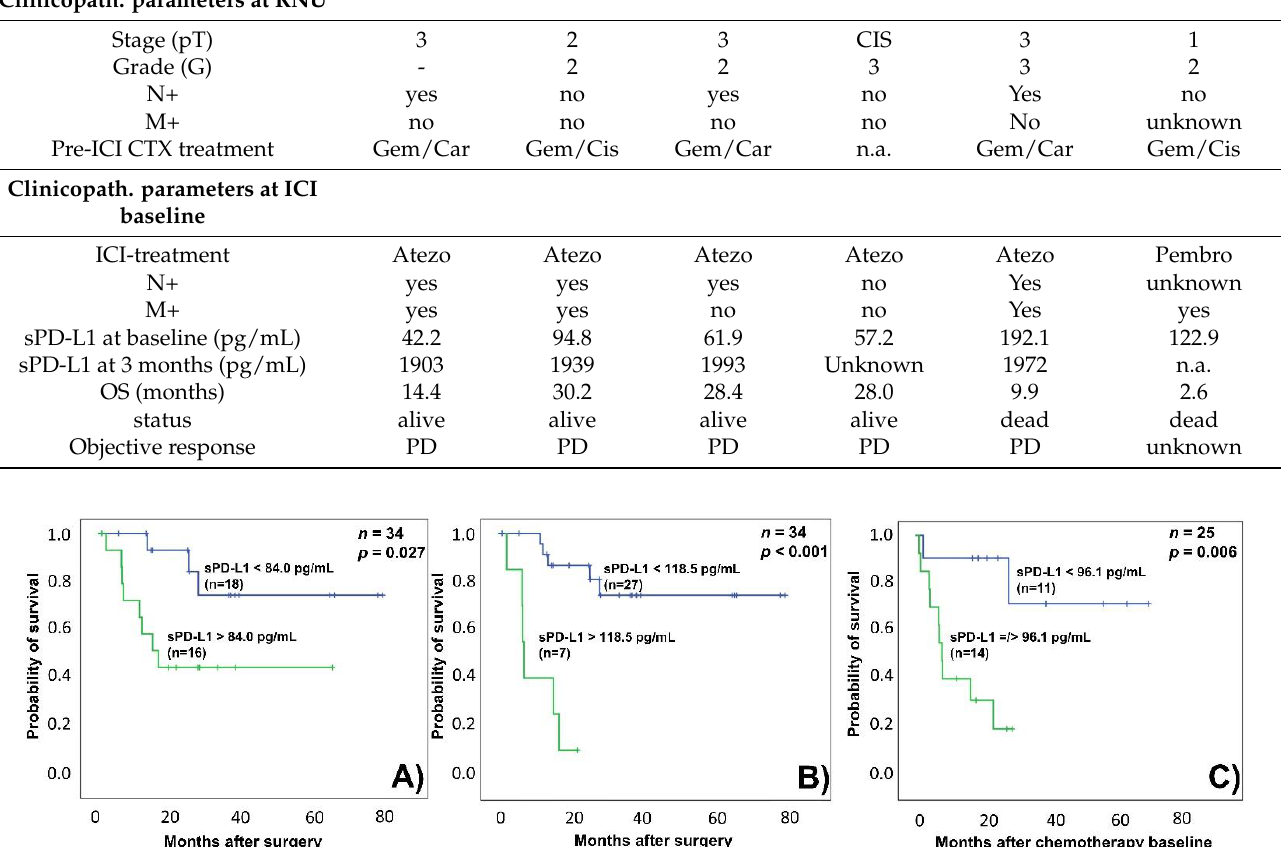
Figure 2. Kaplan–Meier OS analyses with log-rank tests ( A ) for the RNU cohort using the median (84.0 pg/mL) as the cut-off, ( B ) for the RNU cohort applying the ROC-based (118.5 pg/mL) cut-off, ( C ) for the CTX cohort with the median (96.1 pg/mL) cut-off (in this cohort, median- and ROC-based cut-off values resulted the same groups) (blue line—low sPD-L1 cc., green line—high sPD-L1 cc., cut-off values are shown on each